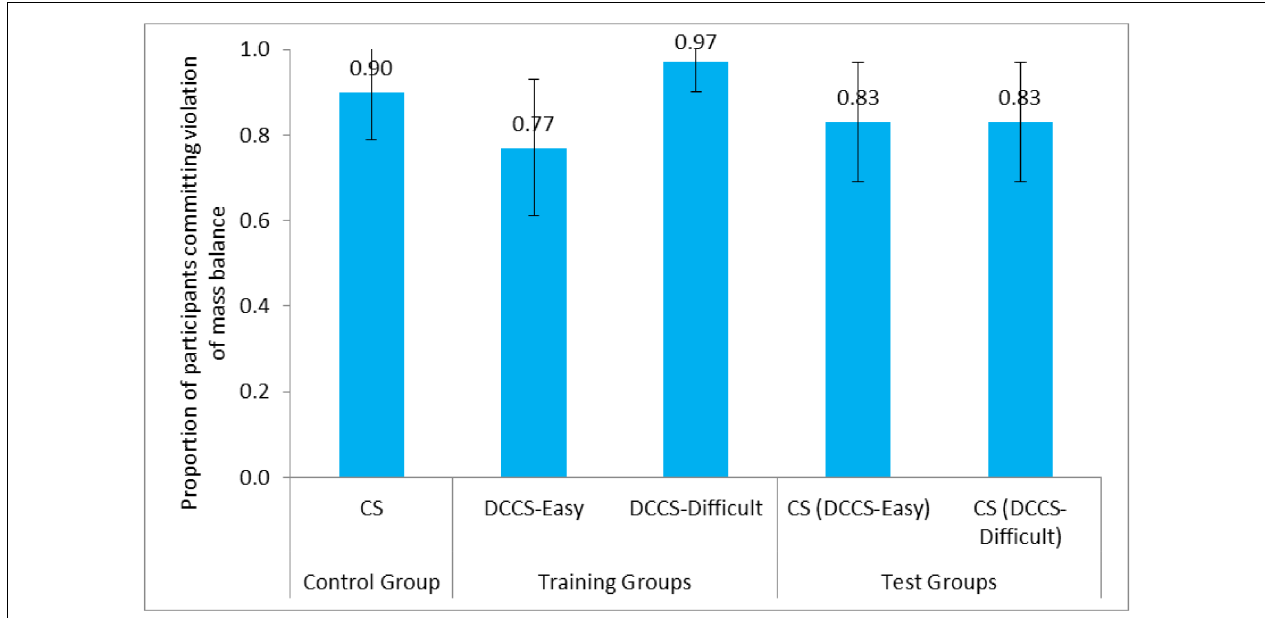
FIGURE 11 | Proportion of participants committing violation of mass balance in three conditions: DCCS-Easy, DCCS-Difficult, and CS conditions. The CS (DCCS-Easy) task and CS (DCCS-Difficult) task refer to CS tasks following the DCCS performance in the DCCS-Easy and DCCS-Difficult conditions. The error bars represent 95% confidence interval around the point estimate.